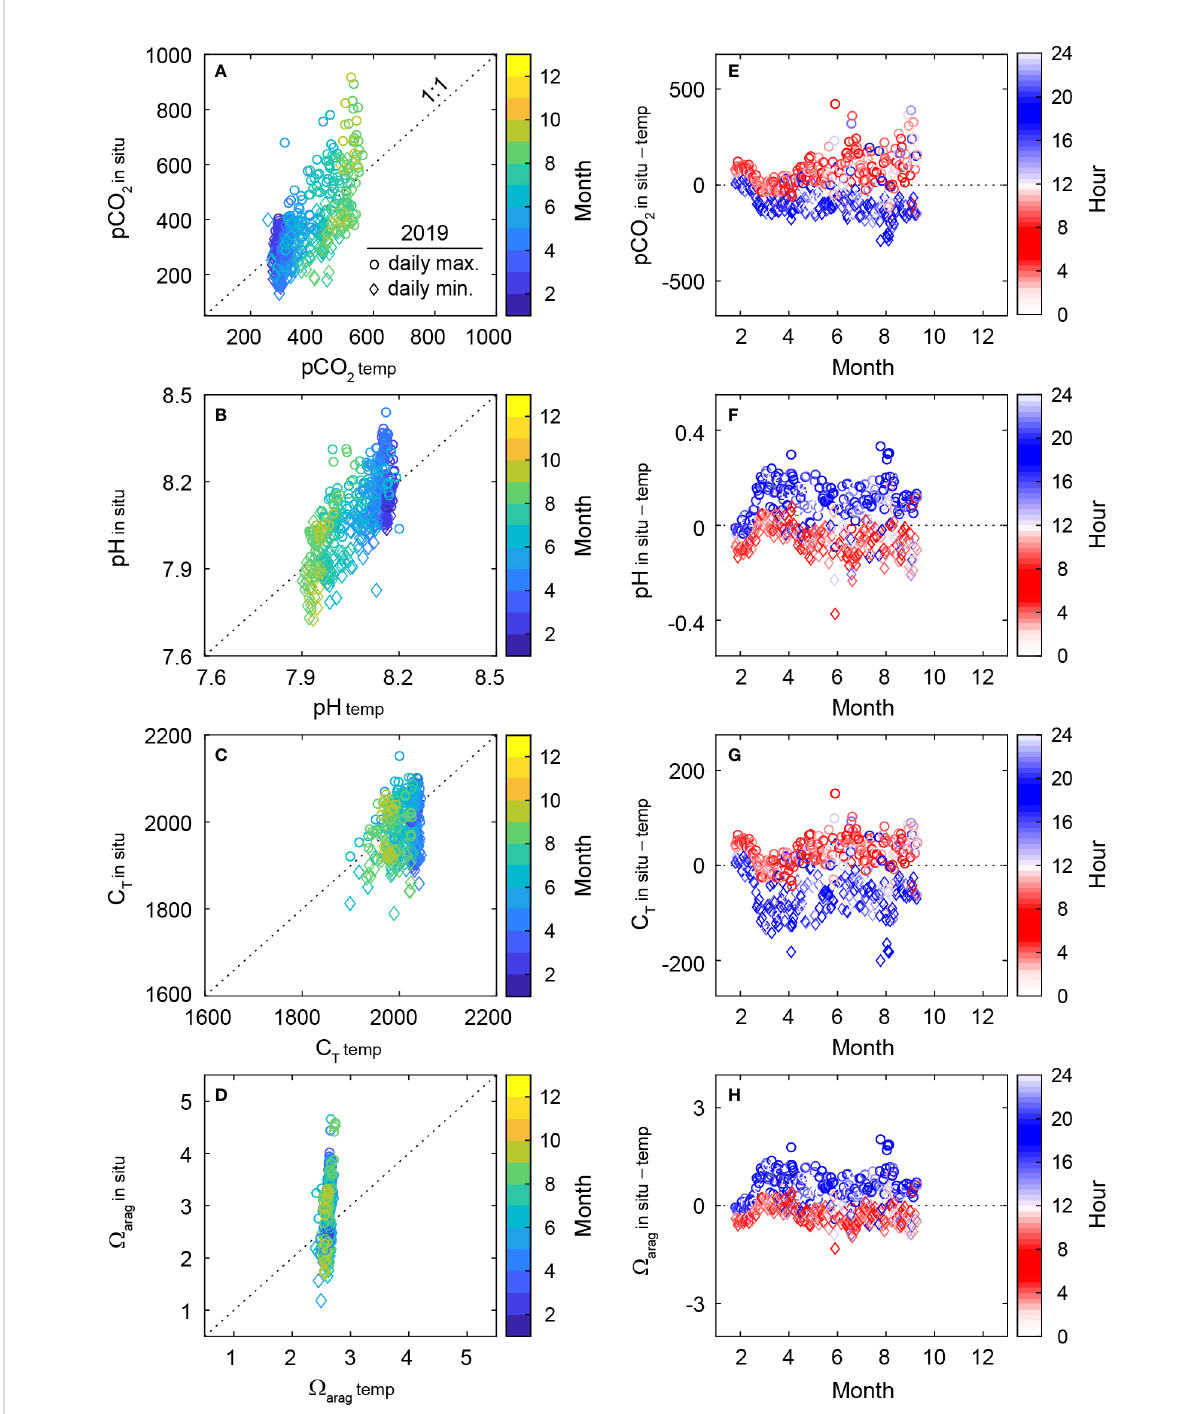
FIGURE 4 (A – D) Relationship between the in situ carbonate parameters (C in situ ) obtained during the continuous measurements and the parameters resulted from the change of temperature (C temp : calculated from the estimated pCO 2 based on thermodynamic shifts in the closed system and A T under the in situ conditions). Only the daily extremes (circles: maximum; diamonds: minimum) observed in 2019 are displayed to conserve space with a color-coding by month. (E – H) The daily extreme differences between C in situ and C temp during the continuous measurements in 2019. The color of the symbols overlaid by the time of measurement. The data for the year 2020 is shown in Supplementary Figure